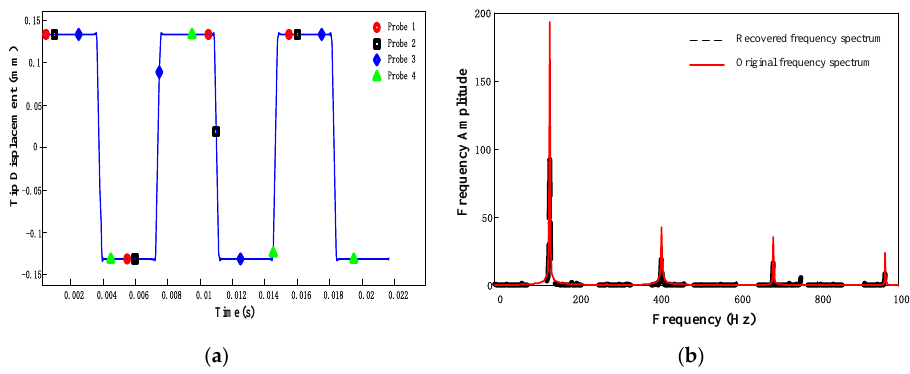
Figure 11. Tip vibration signals and its corresponding spectrums ( a ) tip deflection data sampled by acceleration transducer and BTT sampling system ( b ) frequency spectrum of original vibration signal and recovered spectrum by BP method.